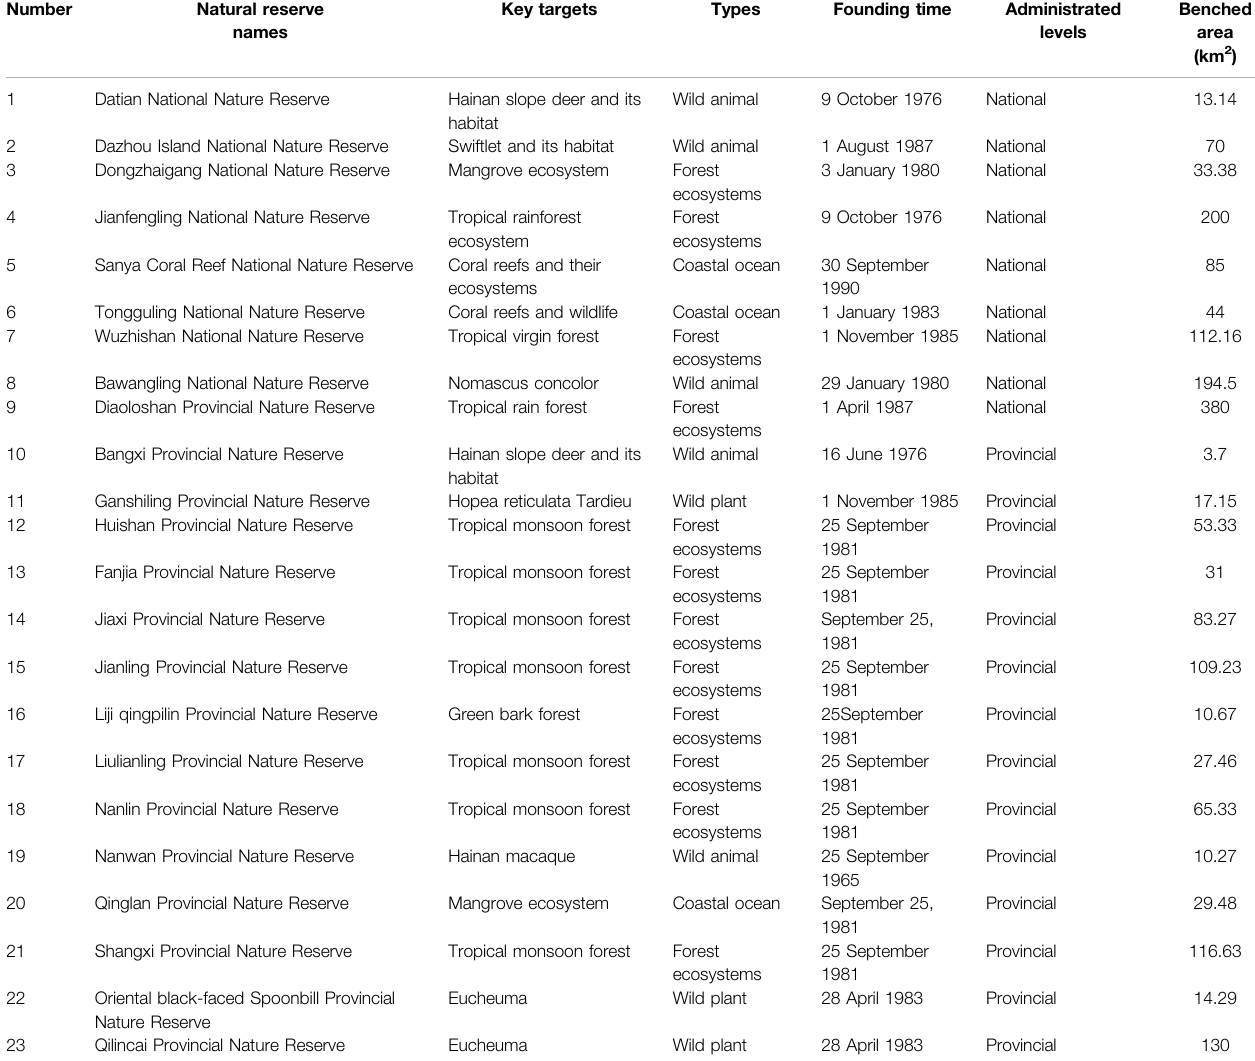
TABLE 1 | Overview of Hainan Island natural reserves.